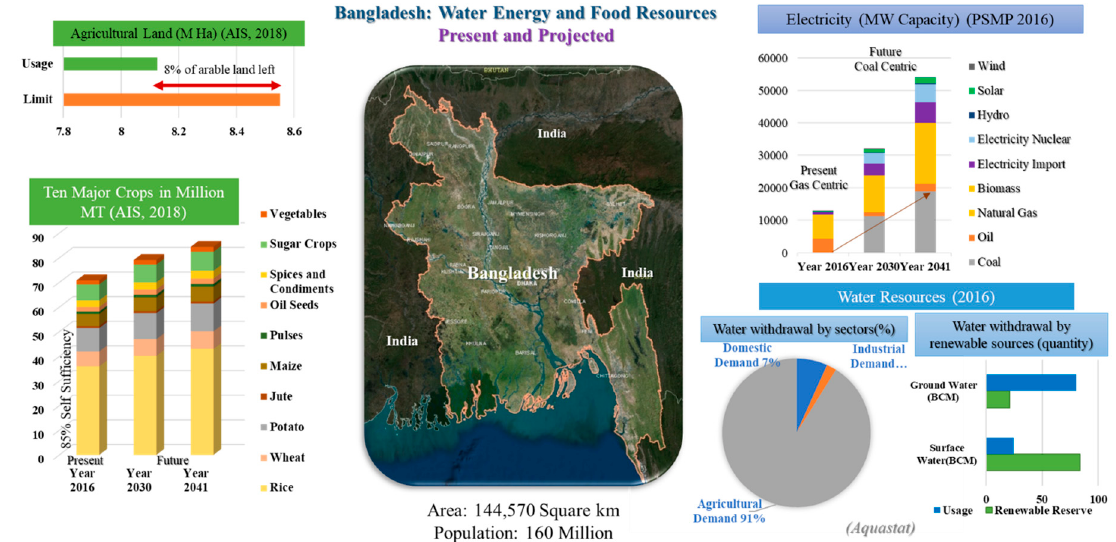
Figure 1. Resource balance and future resource demand of